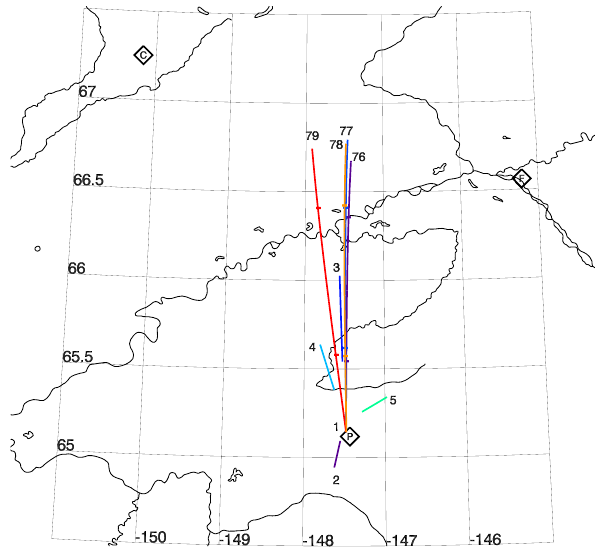
Figure 2. Four payload trajectories (76, 77, 78, 79) and five PFISR radar beams (1, 2, 3, 4, 5) projected on a map of central Alaska. The points of intersection at 95km altitude on upleg and downleg are marked with a short dash. The diamonds indicate the launch site, Poker Flat (P), and the camera sites for TMA observations at Poker Flat, Ft. Yukon (F), and Coldfoot (C).